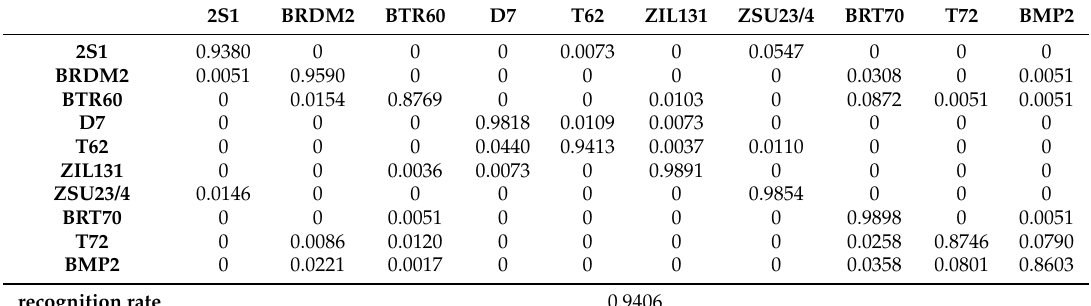
Table 7. The result of supervised discriminative dictionary learning sparse representation (SDDLSR) based on the raw intensity image under SOC.